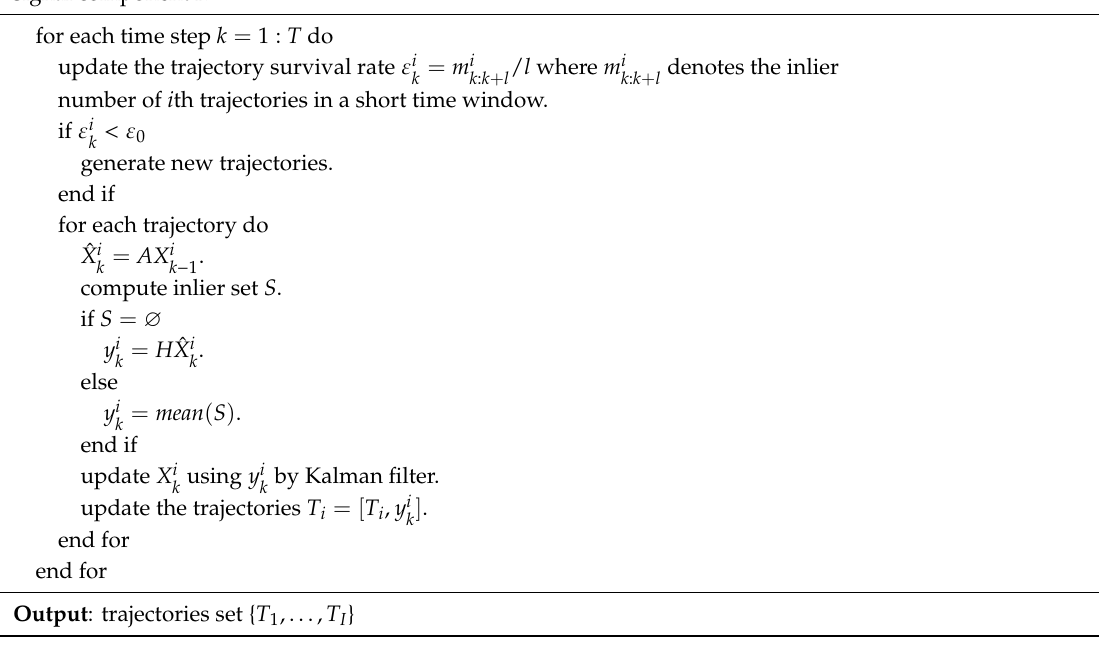
Algorithm 1. The MKF Algorithm.